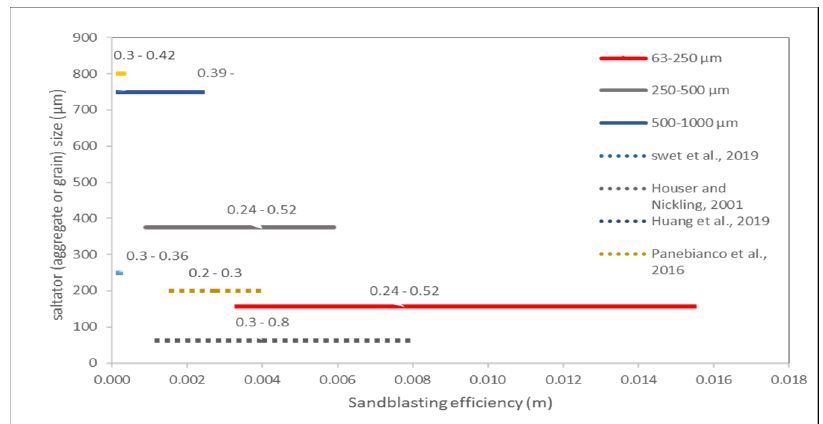
Figure 6. Sandblasting efficiency of the 63–250 µm sample (red), 250–500 µm sample (green), and 500–1000 µm sample (blue). The size is represented by the mean of the size fraction of the aggregate samples. The chart shows some previous works (dashed line) showing the results with different shear velocities. The range of the sandblasting efficiency in each work is related to the range of shear velocity applied at work.